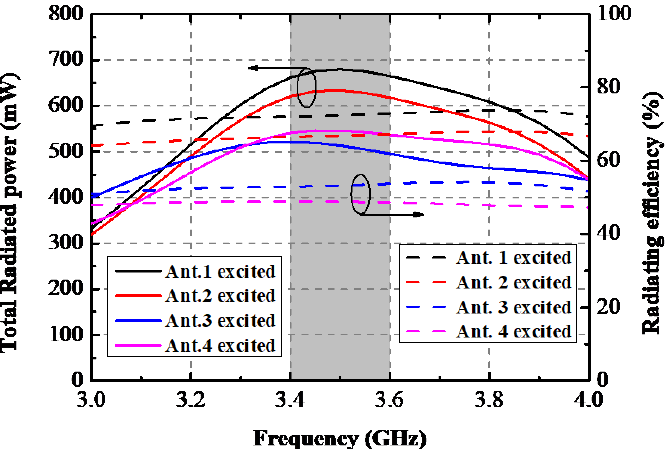
Figure 8. Simulated TRP and radiating efficiency of every antenna element.